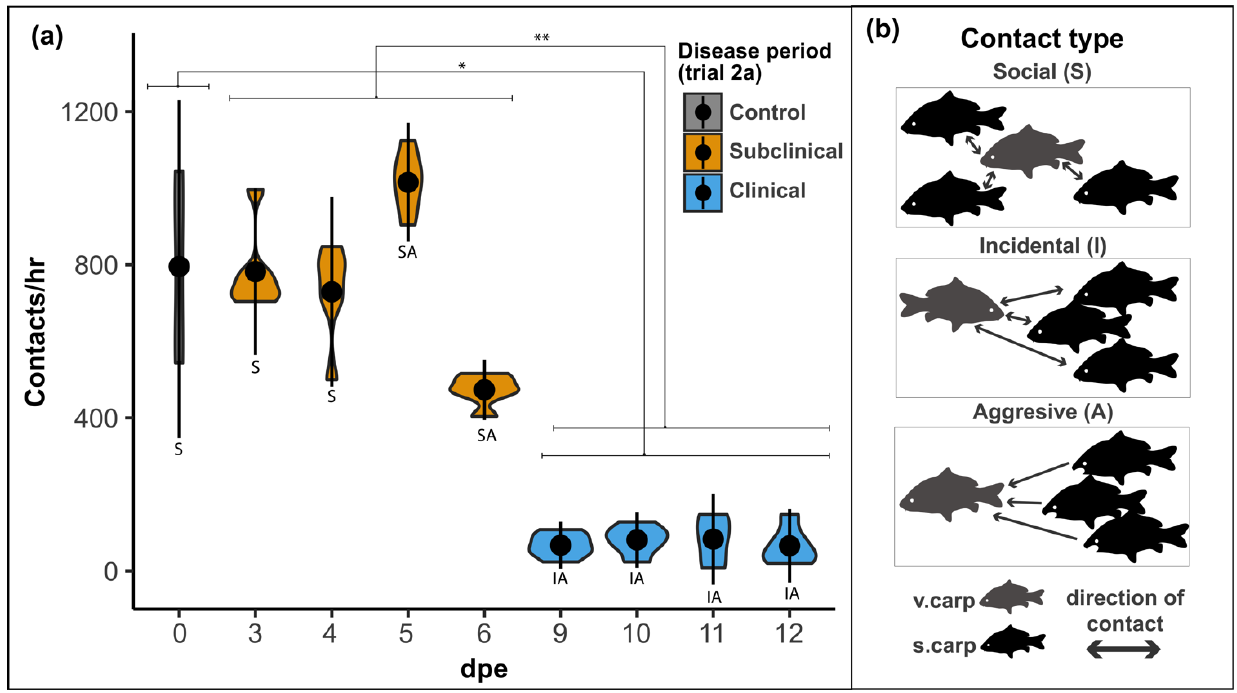
Figure 6. Contact rate and types in Trial 2a. ( a ) violin plot of contact/hr for Trial 2a replicates. ( b ) key for contact types observed in trial 2a. * = p < 0.05, ** = p < 0.001. Expressed as minutes of close contact, the average time necessary to transmit CyHV- 3 during Trial 2a was 20.61 + 10.22 min of physical contact and ranged between 4.48 min